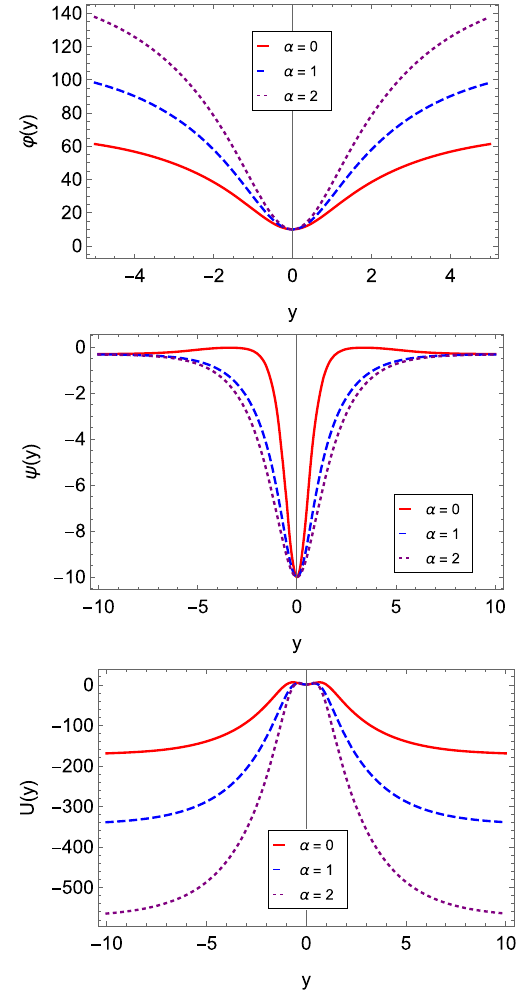
Fig. 1 Numerical solutions for ϕ( y ) (top panel), ψ( y ) (middle panel) and U ( y ) (bottom panel) from Eqs. (23), (26), and (28) with ϕ 0 = 10 = − ψ = k = φ = 1, A = 4 / 9, and A = − 1 / 9, for different 0 , U 0 0 0 1 values of